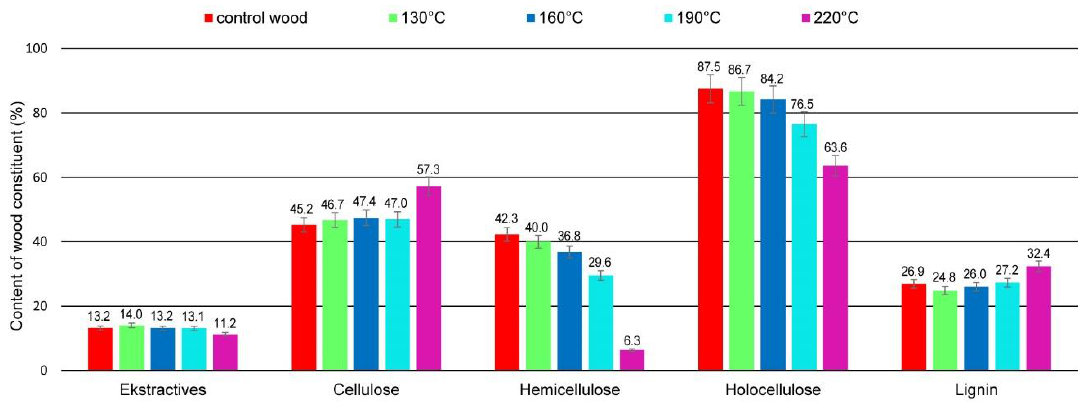
Figure 6. Content of extractives and main components in modified wood.